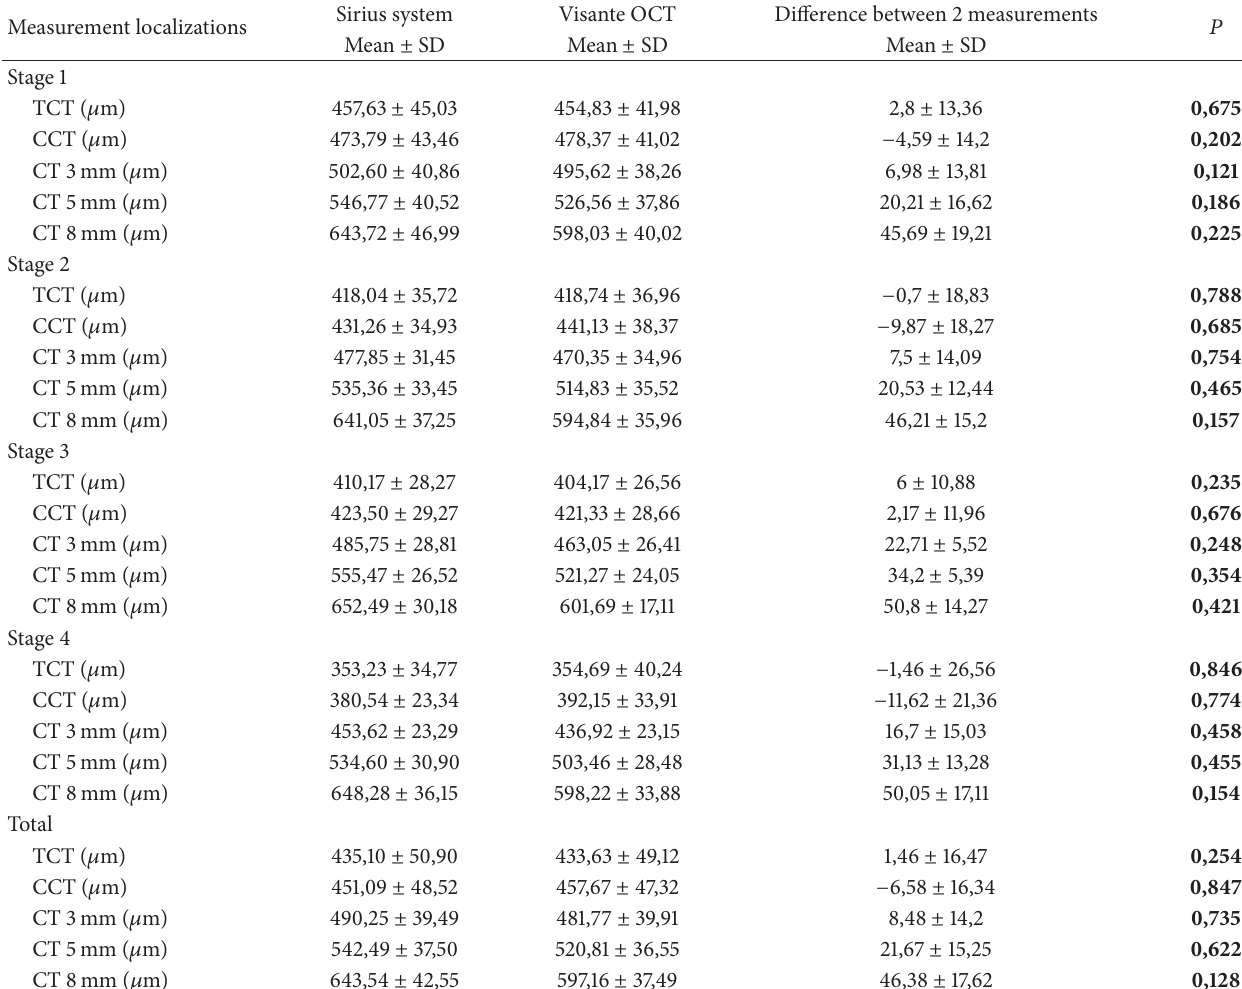
Table 2: Comparative analysis of the Sirius system and the Visante OCT measurements in different stages of keratoconus. Measurement localizations